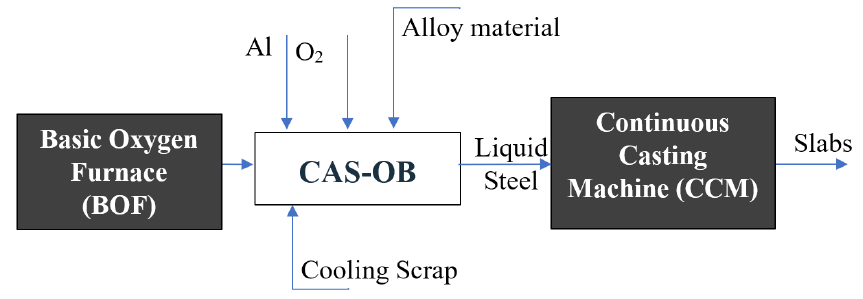
Figure 6. Diagram of the steelmaking process summarised.